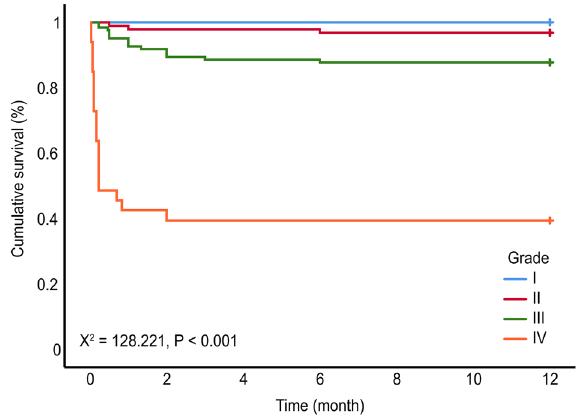
Figure 1. Kaplan ‒ Meier survival curves of patients with different grades.